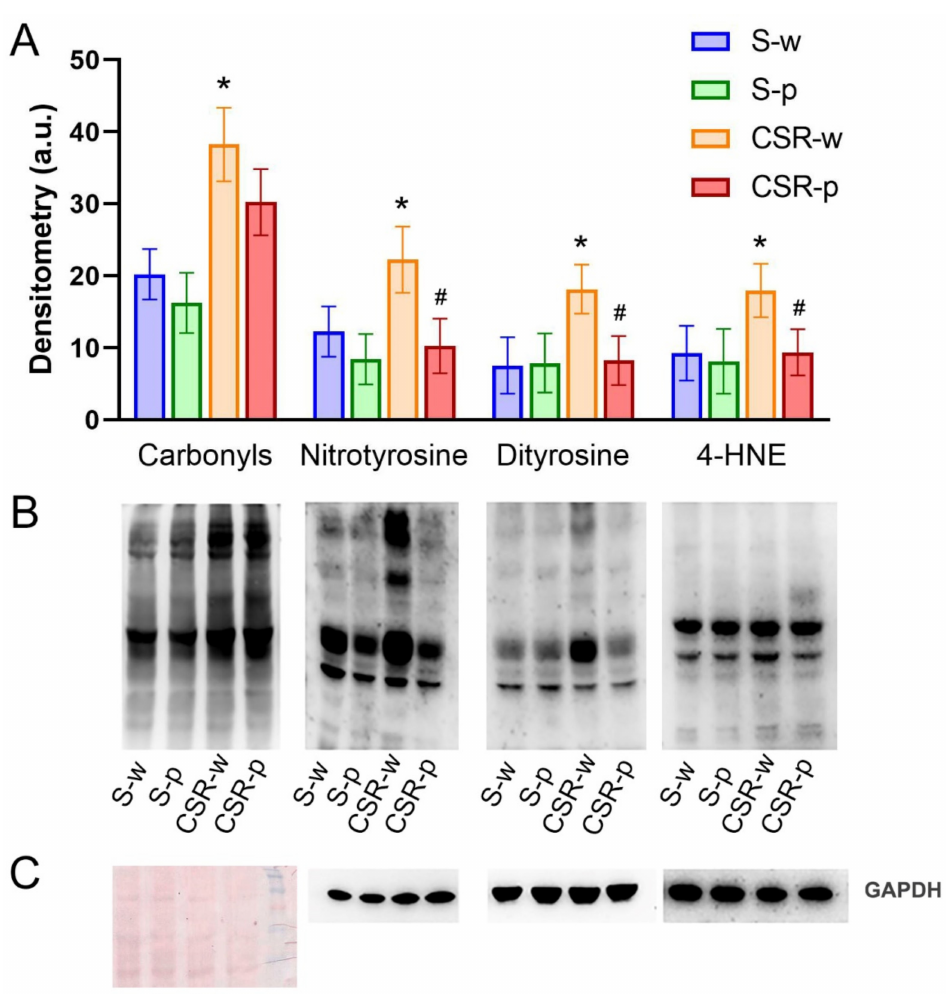
Figure 2. Effects of CSR and SLAB51 on protein and lipid oxidation. ( A ). Quantification of protein carbonyls, nitrotyrosine, dityrosine, and lipid 4-HNE adduct in brain homogenates in all groups of mice. The densitometric analyses obtained from three separate blots. Values are expressed as mean ± standard error. One-way ANOVA results were (F (3, 24) = 9.277; p = 0.0003) for carbonyls, (F (3, 24) = 7.550; p = 0.001) for nitrotyrosine, (F (3, 24) = 5.431; p = 0.00539) for dityrosine, and (F (3, 24) = 3.967; p = 0.01183) for lipid 4-HNE. * indicates statistical significance between S-w and CSR-w, while # indicates statistical significance between CSR-w and CSR-p. ( B ). Representative immunoblots for protein carbonyls, nitrotyrosine, dityrosine, and lipid 4-HNE adduct. ( C ) . Equal protein loading for nitrotyrosine, dityrosine, and 4-HNE adducts were verified by using an anti- GAPDH antibody. Ponceau staining has been used to check loading in oxyblot. Molecular weight standards (6–205 kDa) were used for molar mass